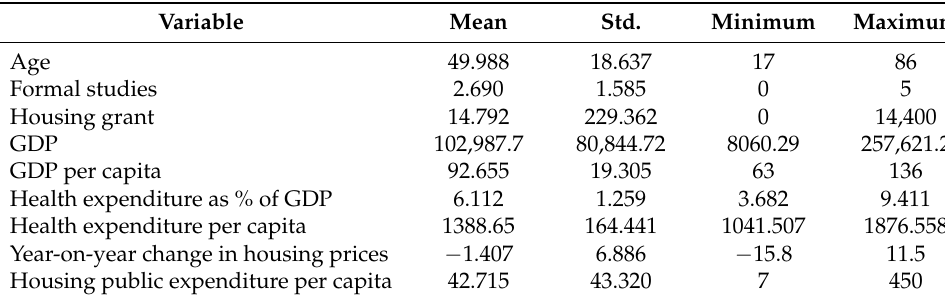
Table 2. Statistical descriptions of continuous